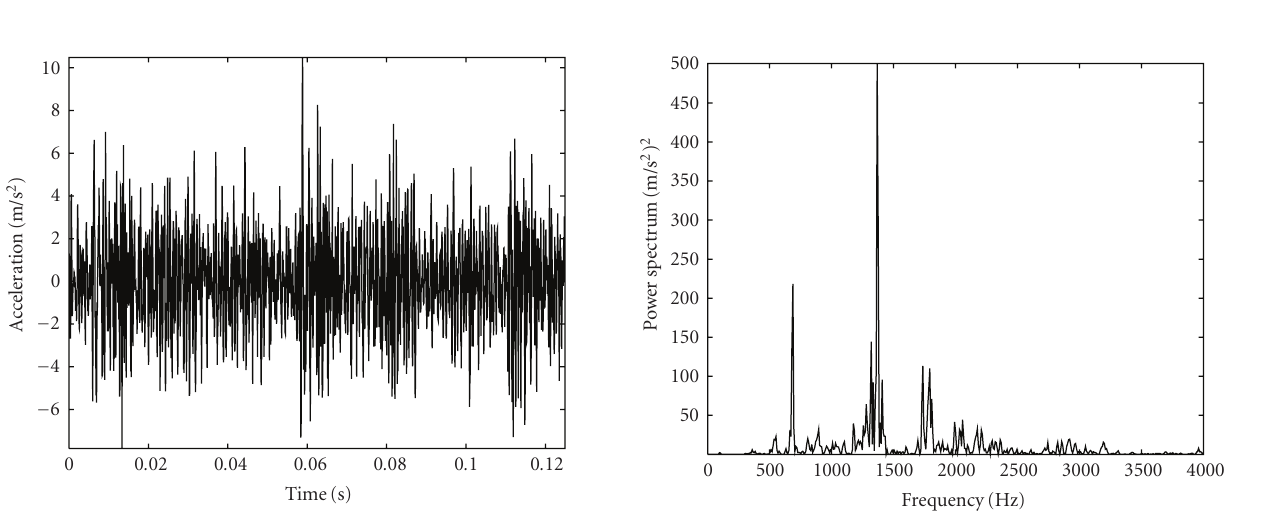
Figure 7: Experimental set-up.